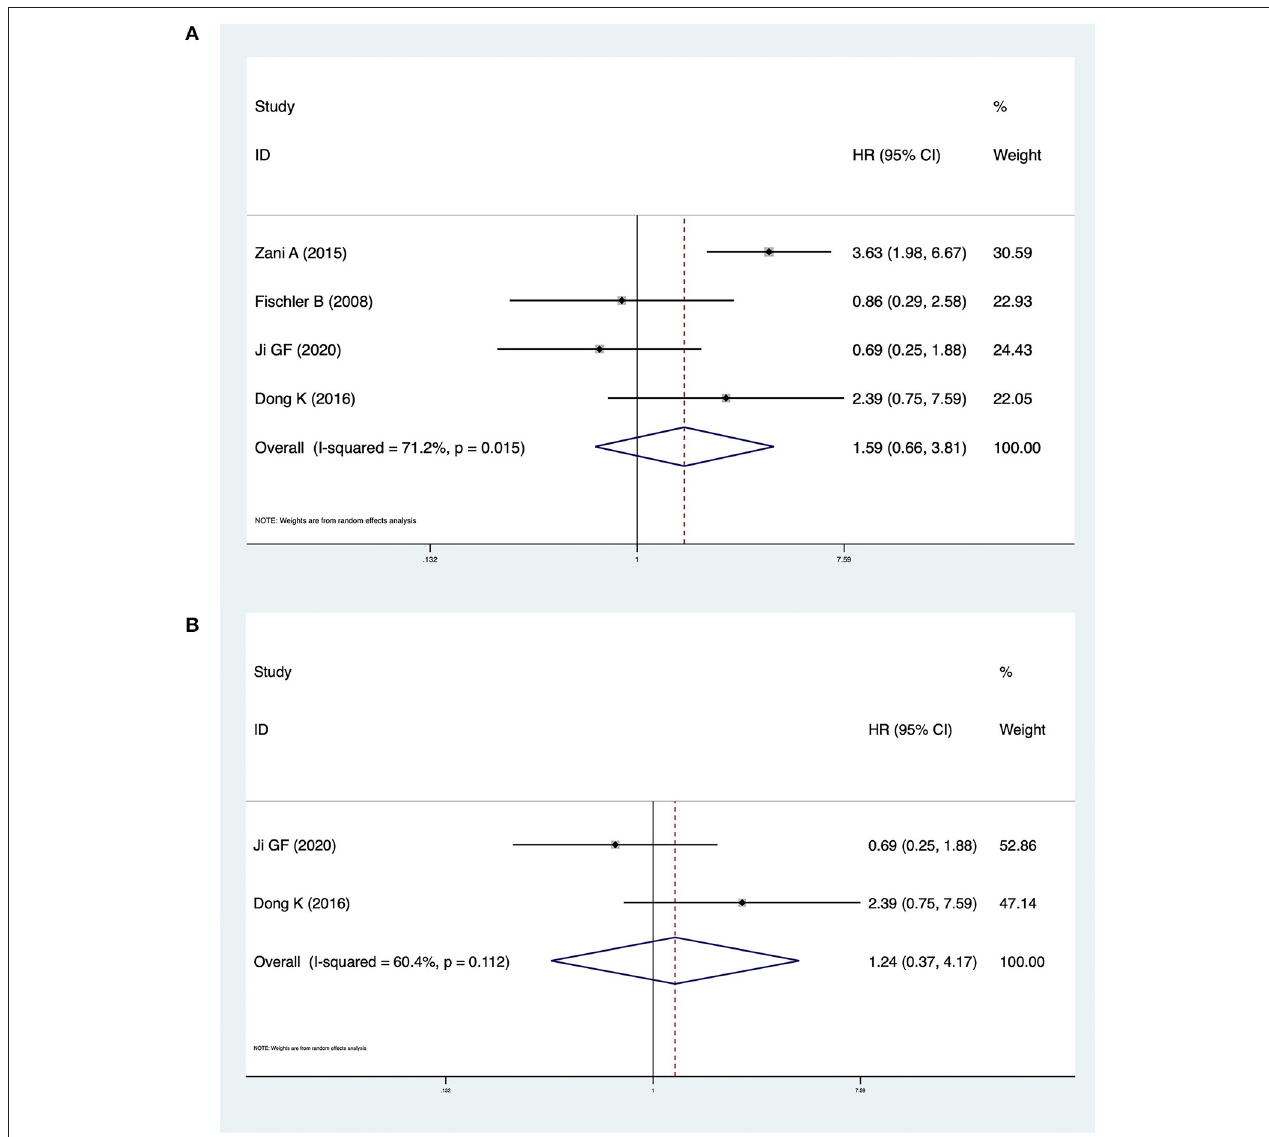
FIGURE 4 | (A) Forest plot of the NLS in CMV + BA vs. CMV − BA. (B) Forest plot of the NLS in CMV + BA vs. CMV − BA in